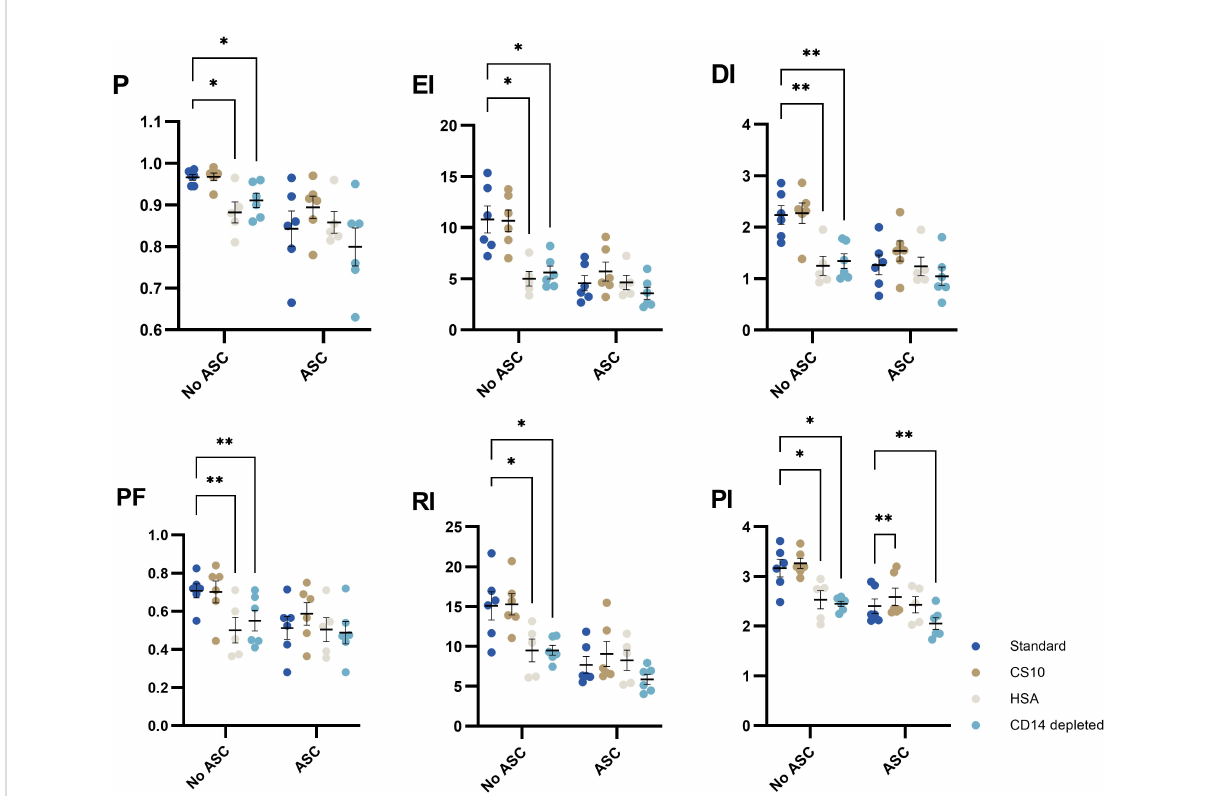
FIGURE 7 The impact of cryomedia and monocyte-depletion on the proliferative response of PHA-stimulated T cells in absence or presence of ASCs, represented by 6 proliferative metrics (P, EI, DI, PF, RI and PI). PBMC were either cryopreserved in 90% FBS with 10% DMSO (standard), 12.5% HSA in RPMI with 10% DMSO, or CS10. Monocyte-depleted cells were cryopreserved in standard. Mixed-effects model. Signi fi cance levels of *) p < 0.05; **) p < 0.01. n= 6 except for HSA (n=5). PHA, Phytohemagglutinin; ASC, Adipose tissue-derived Stromal Cells; PBMC, Peripheral Blood Mononuclear Cells; HSA, Human Serum Albumin; CS10, Cryostor CS10; P, Fraction diluted/Proliferating cells; EI, Expansion Index; DI, Division Index; PF, Precursor Frequency; RI, Replication Index; PI, Proliferation